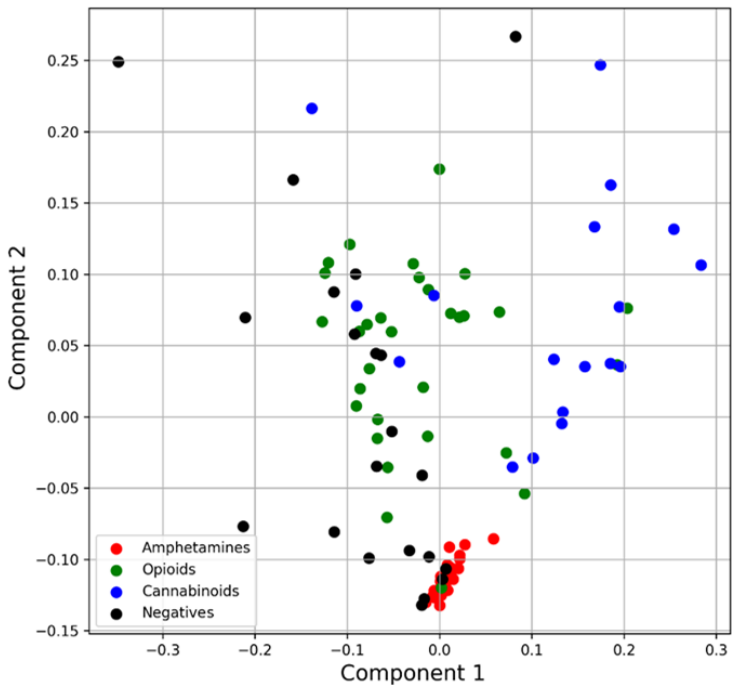
Figure 3. Score plot of the first two components of a three-component ICA displaying the class of amphetamines (red), opioids (green), cannabinoids (blue), and negatives (black). Inventions 2023 , 8 , x FOR PEER REVIEW